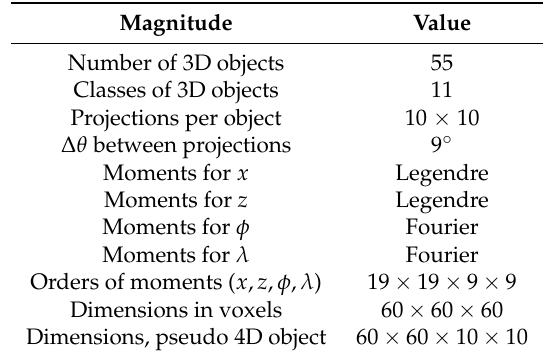
Table 3. Summary of data